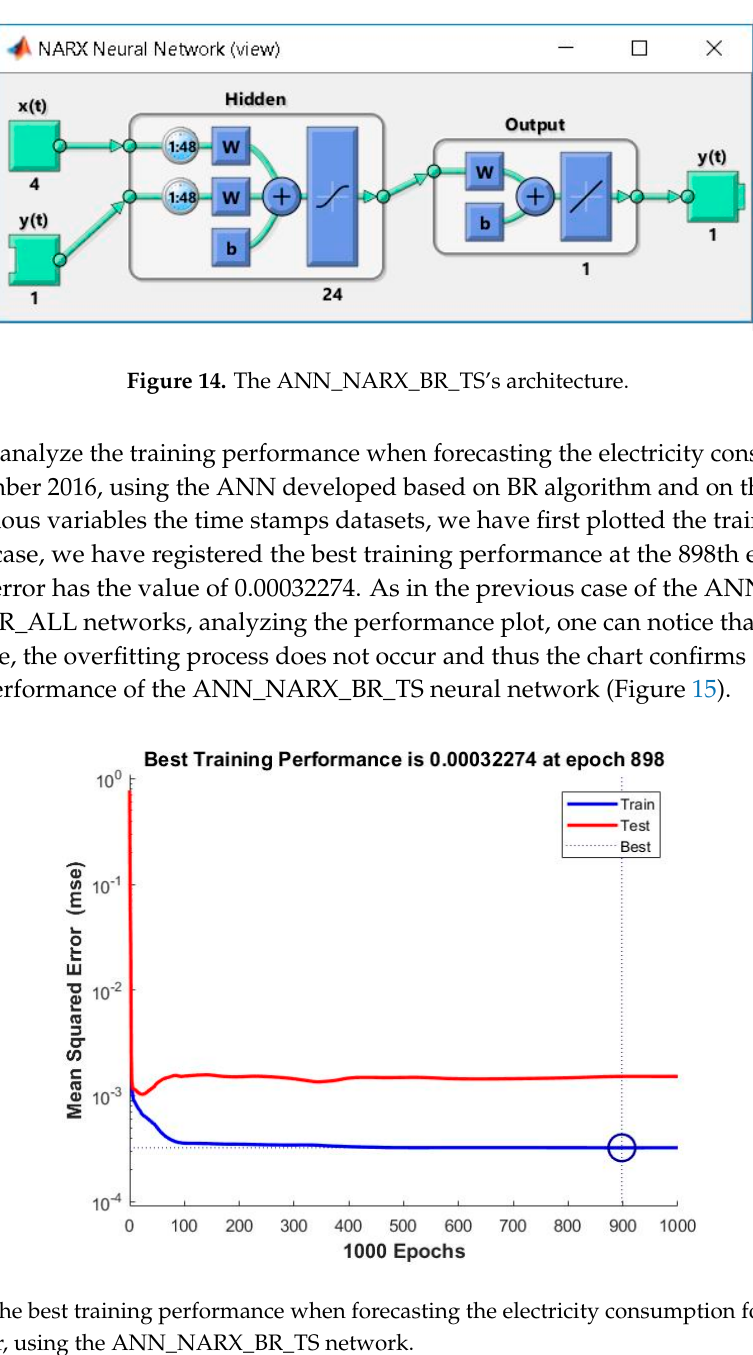
Figure 16. The error histogram when forecasting the electricity consumption for the month of December, using the ANN_NARX_BR_TS network.